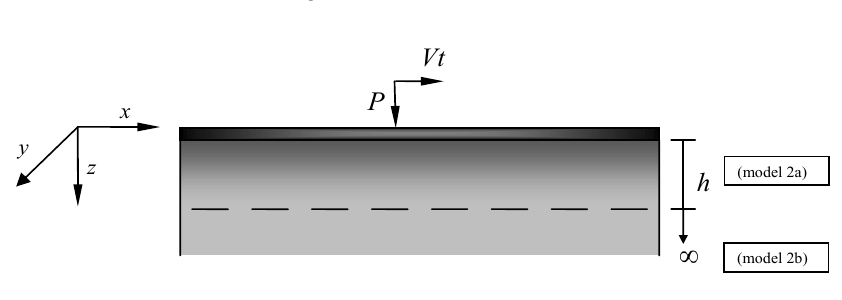
Fig. 2. The beam on the